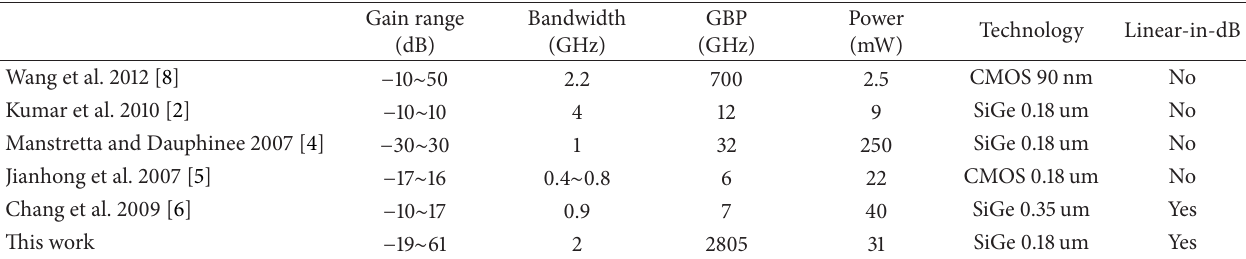
Table 1: VGA performance